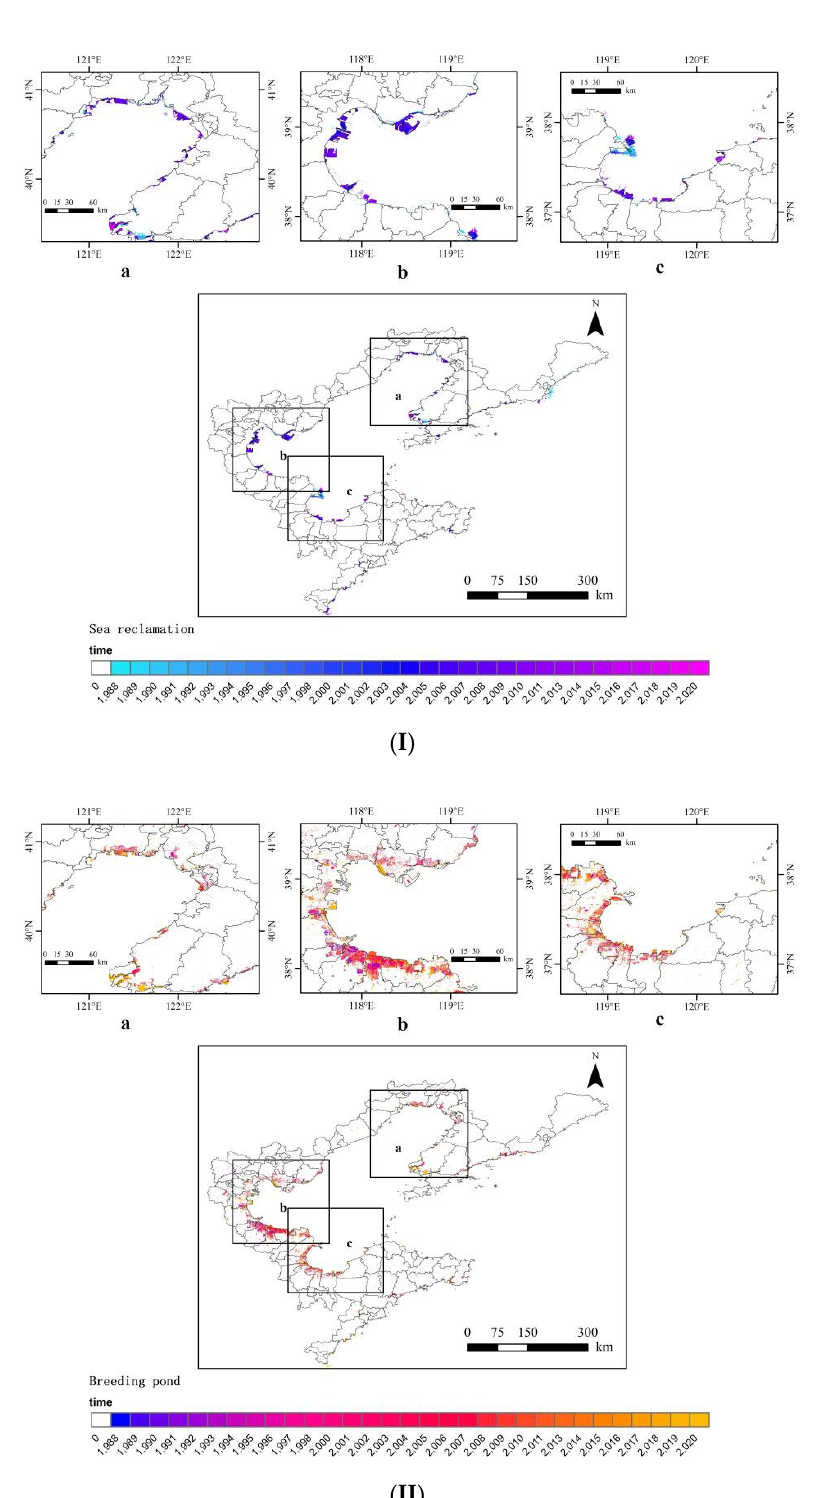
Figure 5. Mapping results of long-term land reclamation ( I ) and aquaculture ( II ).